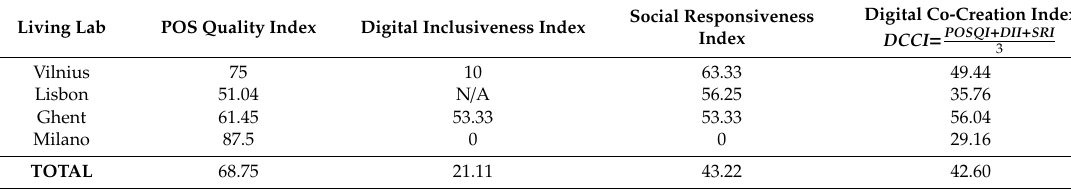
Table A4. Indexes of 4 Living Labs analyzed during the